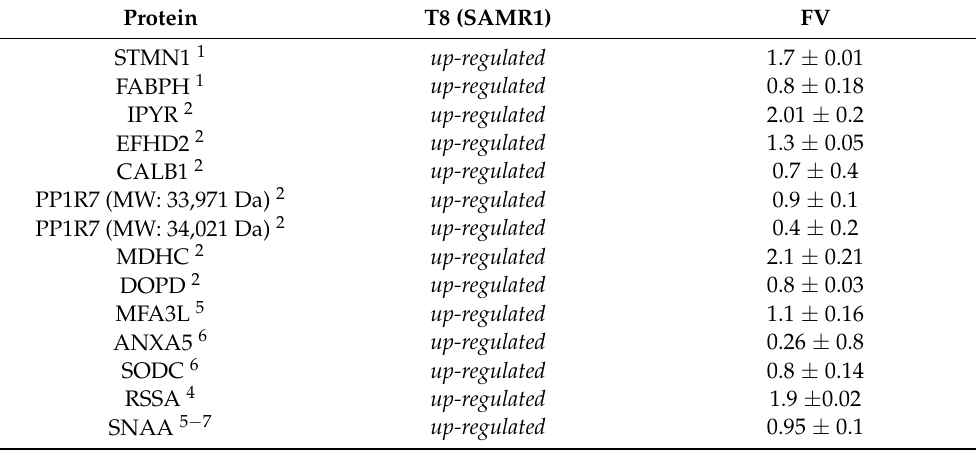
Table 3. Neuroproteome changes in 8-month-aged